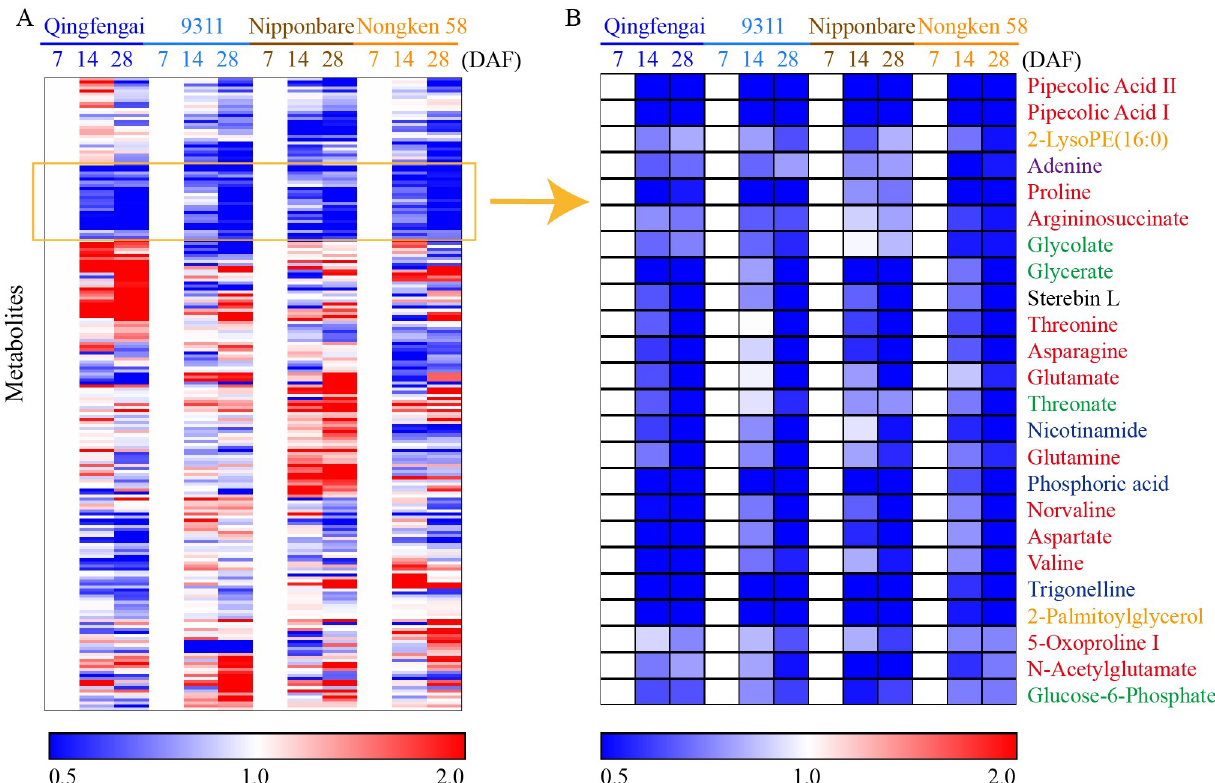
Fig 4. Heat map of metabolite changes in flag leaves from 7 DAF to 28 DAF. Q, Nip and N represent Qingfengai, Nipponbare and Nongken 58, respectively. Ratios of fold changes are given by shades of red or blue colors according to the scale bar. Data represent mean values of four biological replicates for each cultivar and time point. For full metabolite names, refer to S2 Table.